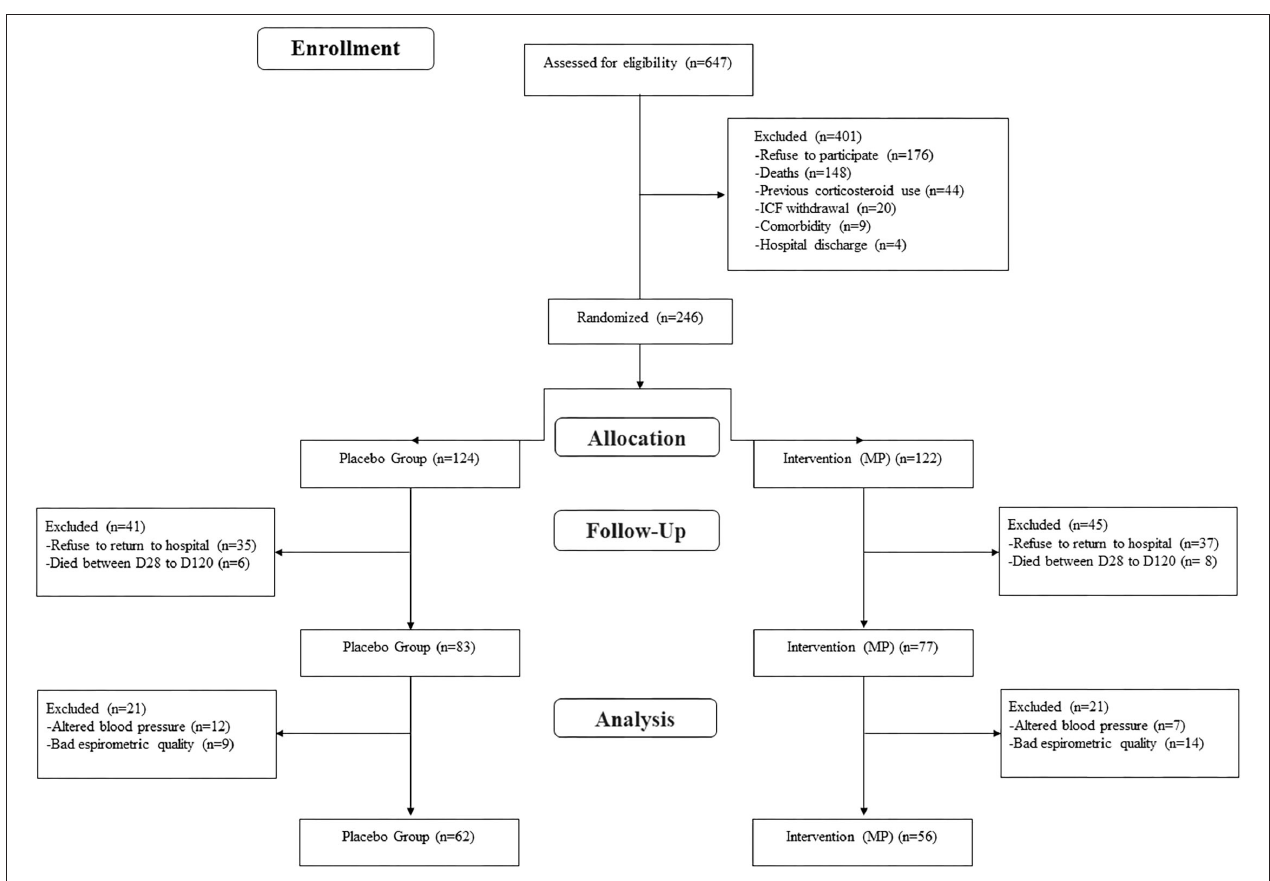
FIGURE 1 | Study flow chart of the Metcovid trial survivors who performed pulmonary function